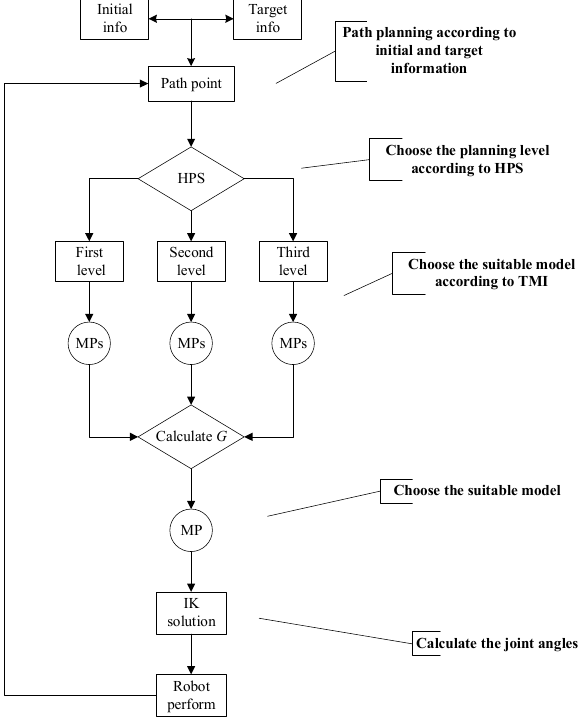
Figure 6. The flow chart of the decision ‐ making algorithm.